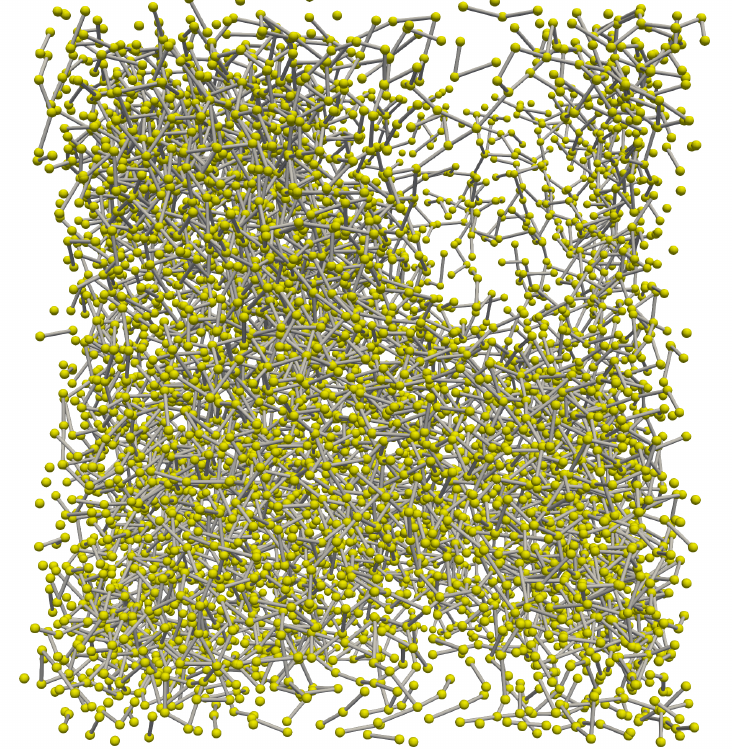
Figure 6. Snapshot of the polymeric structure with an initial radical concentration of 3% and a 40% double bonds conversion without the pressure correction term. Note that the bonds crossing the periodic boundaries are not drawn in the